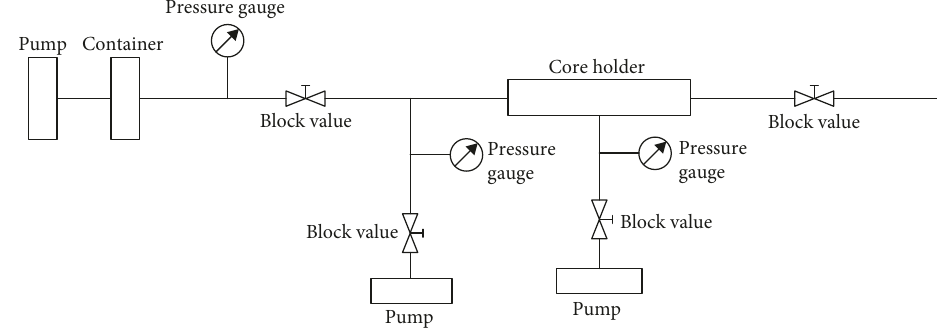
Figure 1: Rock compressibility stress sensitivity experimental process.